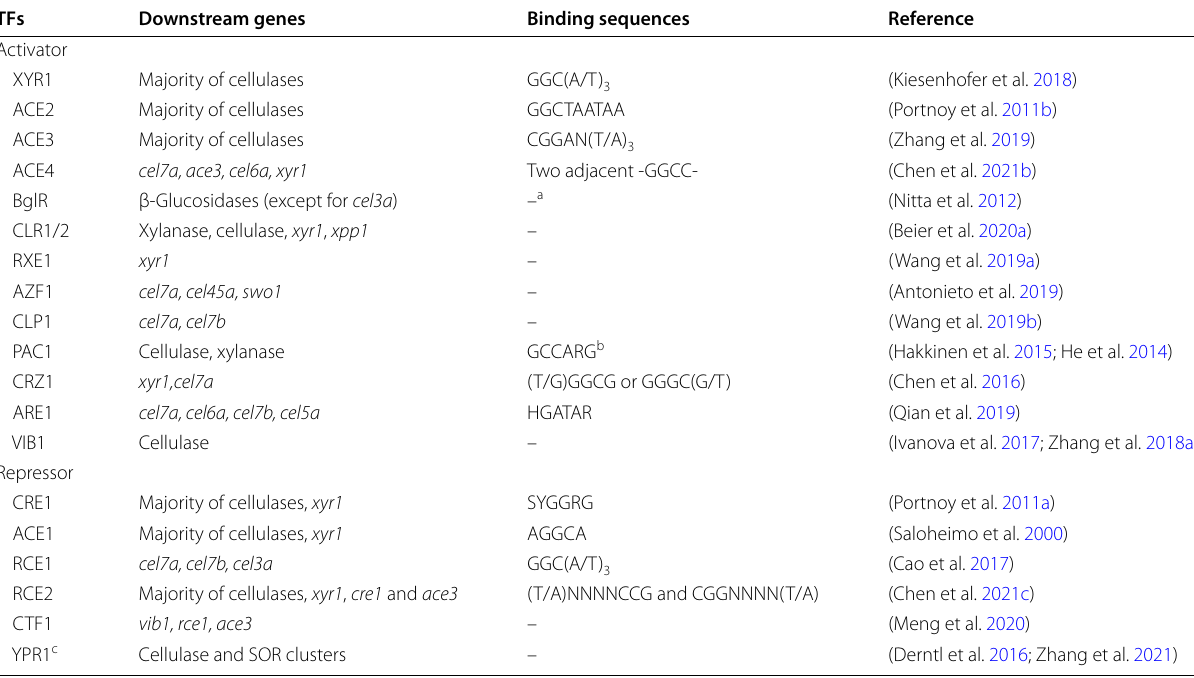
a Indicates uncharacterized binding sequences b Indicates components and sequences verified in other fungi, not in T. reesei c Indicates YPR1 is a activator for SOR clusters, but its overexpression has negative effect for cellulase expression. And we classify YPR1 into the repressor for